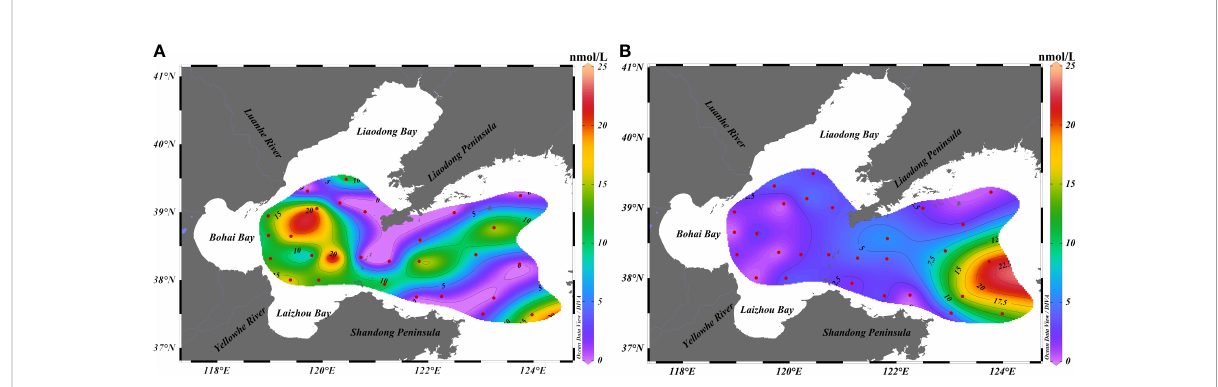
FIGURE 2 Horizontal distribution of DMS in the surface waters of BS and NYS in summer and autumn. Horizontal distribution of DMS in (A) summer and (B)